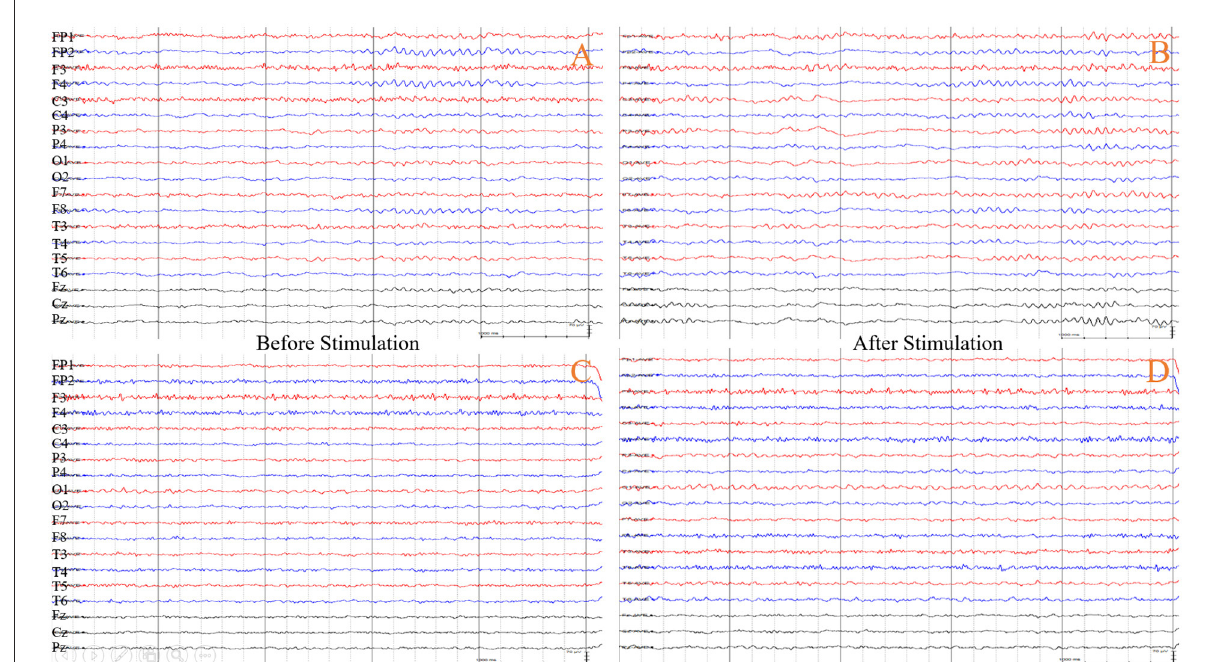
FIGURE4 EEG responsiveness to different stimulation frequencies of st-SCS in a patient (he chose 5Hz as the treatment frequency). (A) Before the stimulation at 5Hz, the waking EEG background activity showed all lead is characterized by low-medium wave amplitude 9–10Hz alpha rhythm activity, no obvious dominant rhythm in the occipital region, and poor modulation amplitude. (B) After stimulation at 5Hz, the waking EEG background activity shows an increase in frequency to 11–12Hz compared to the (A) , with improved modulation and higher amplitude. (C,D) Before and after stimulation at 70Hz, the waking EEG background activity did not change